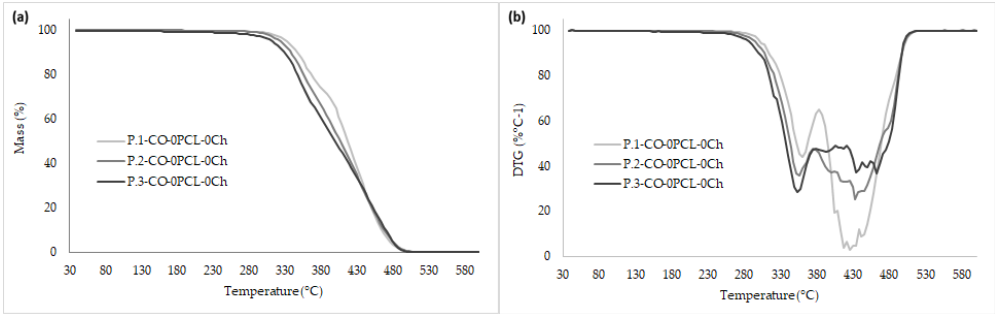
Figure 3. Thermograms of the synthesized PUs. ( a ) Thermogravimetric (TG) curve of PUs; ( b ) Derivative of the thermogravimetric (DTG) curve of PUs.